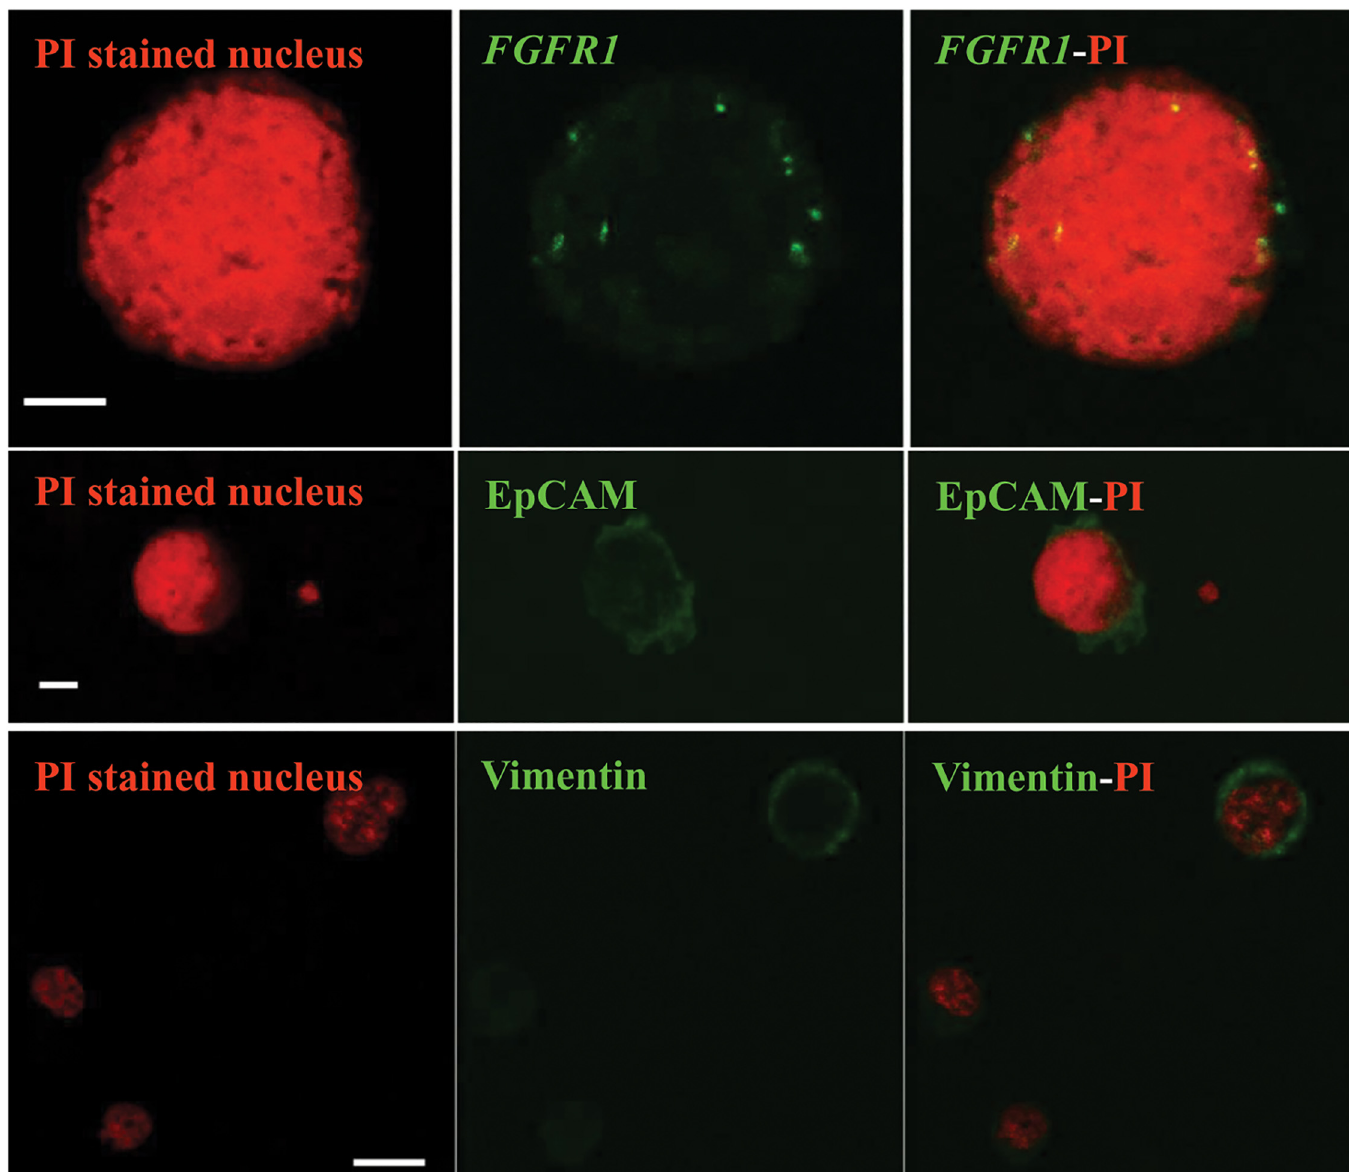
Fig 3. Confocal images of propidium iodide (PI) stained suspicious circulating elements obtained from SQCLC patients. The upper part of the figure shows a PI stained SCE with multiple green signals referring to multiple copies of FGFR1 gene (scale bar = 5 μ m); the middle part shows a PI stained nucleus with EpCAM expression (scale bar = 5 μ m) and the bottom part a PI stained nucleus with vimentin expression (scale bar = 10 μ m) associated with two small leukocytes showing a faint cytoplasmic